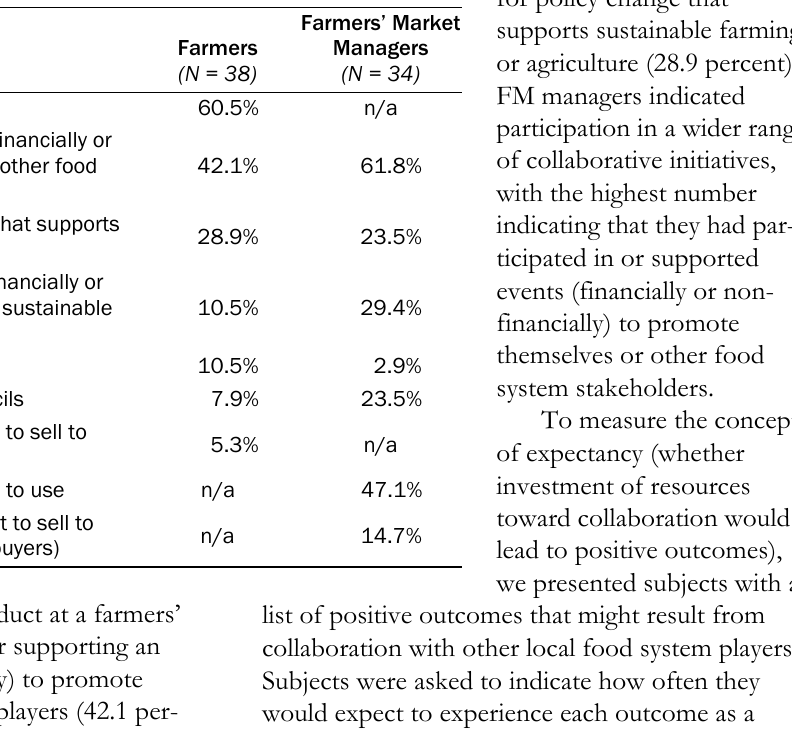
Table 4. Motivation to Collaborate: